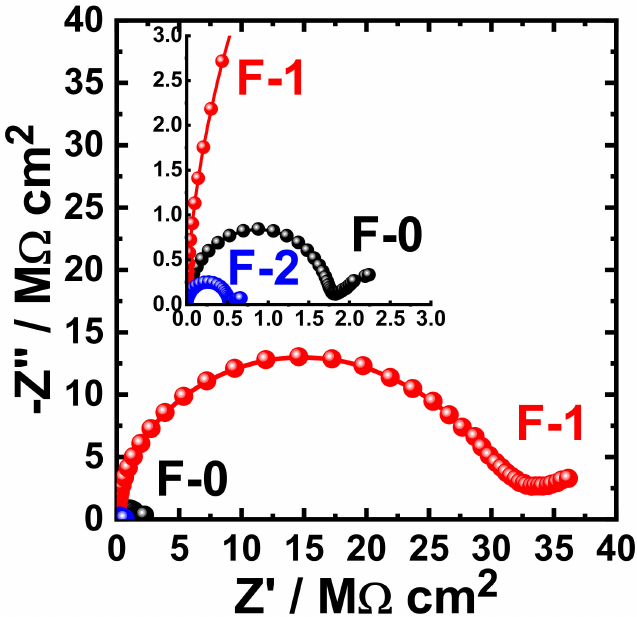
Figure 17. Typical Nyquist plots obtained for F-0, F-1, and F-2 after their immersion in 3.5% NaCl solutions for 14